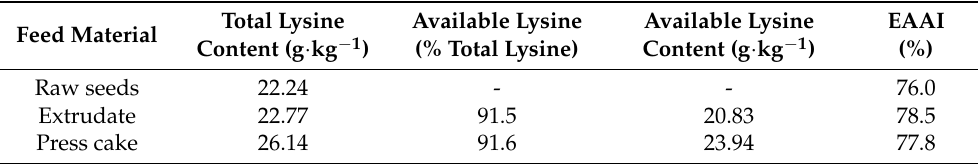
Table 7. The content of total and available lysine and the index of protein value of the raw soybeans and processed feed products (the mean values from 3 soybean varieties).